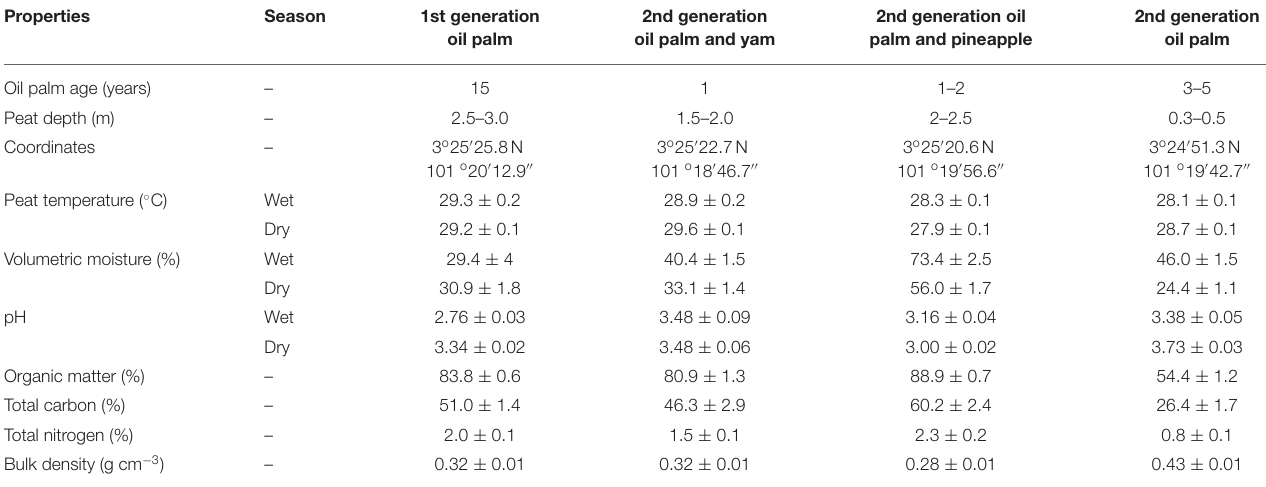
TABLE 1 | Surface (0–5 cm) peat